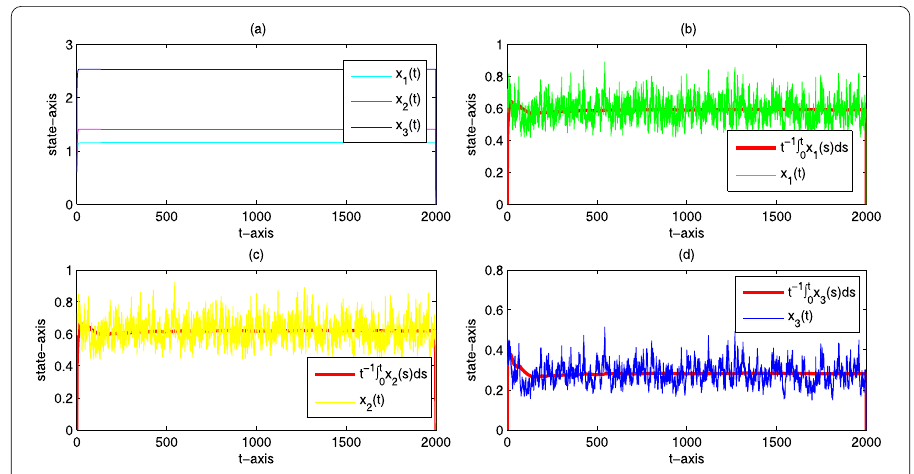
Figure 1 System (1.2) is permanent with σ 1 = σ 2 = σ 3 = 0.1, γ 1 ( u ) = 0.2, γ 2 ( u ) = 1, γ 3 ( u ) = 3. ( a ) shows the stability of the equilibrium state of the corresponding deterministic system while ( b ), ( c ), ( d ) sketch the